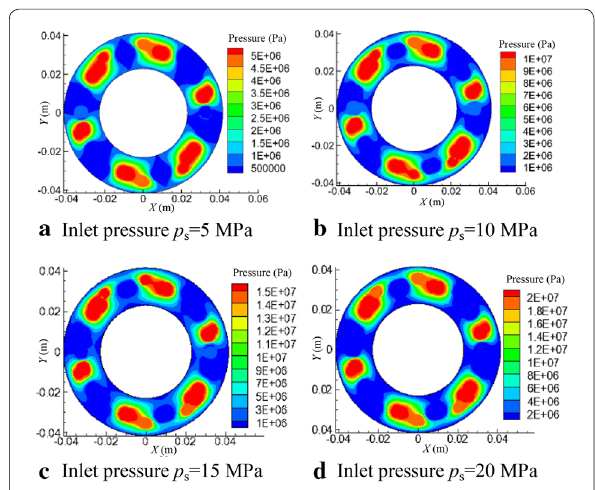
Figure 12 Pressure distribution of port plate pairs at various inlet pressures